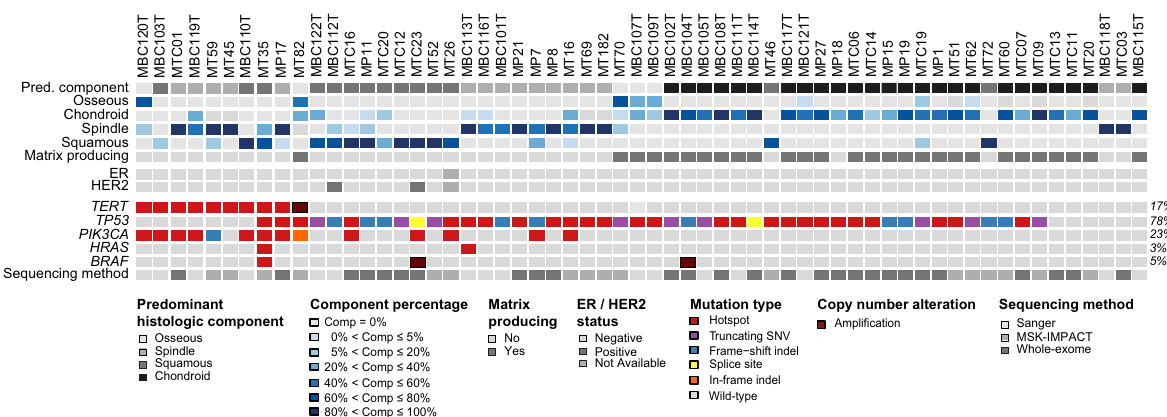
Fig. 2 Recurrent somatic TERT, TP53, PIK3CA , HRAS , and BRAF genetic alterations in distinct histologic subtypes of 60 metaplastic breast cancers. Heatmap depicting the proportion of the histologic component, frequency of TERT genetic alterations, TP53 mutations, PIK3CA mutations, HRAS mutations and BRAF genetic alterations in 60 MBCs. Mutation types are color-coded according to the legend. Cases are shown in columns, the percentage of the histological components, matrix producing, ER and HER2 status, and sequencing methods are depicted in phenobars. *Mutual exclusivity analysis, CoMEt, p < 0.001.